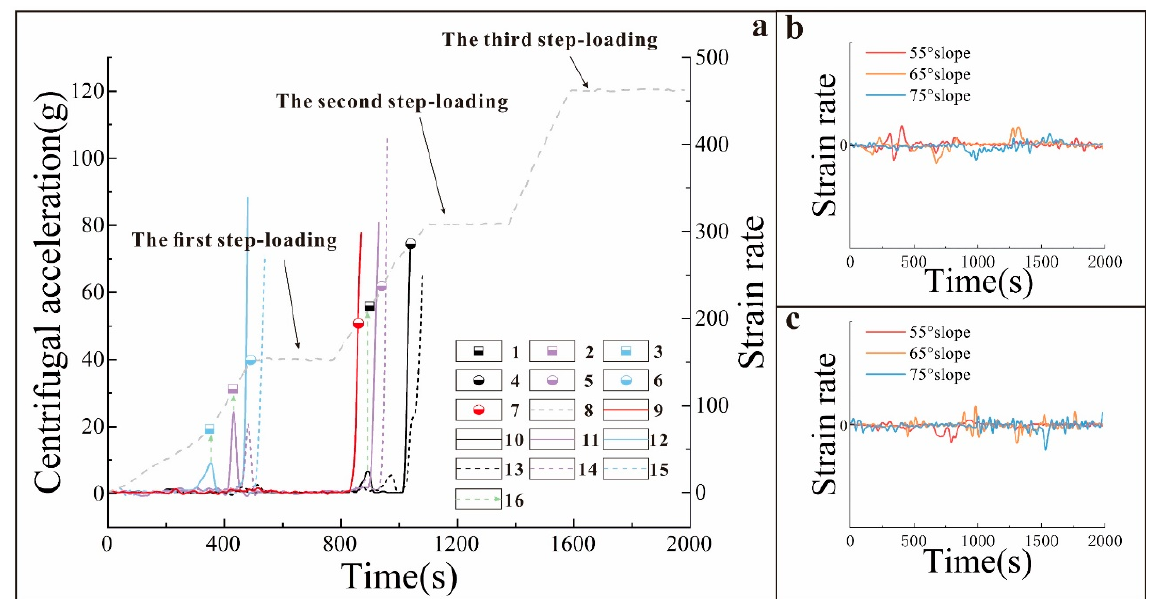
Figure 10. Model slope strain rate curves, ( a ) acceleration values and strain rate of key nodes in the development of the toppling bending zone, 1 rupture of 55° slope foot, 2 rupture of 65° slope foot, 3 rupture of 75° slope foot, 4 first-level toppling zone of 55° slope, 5 first-level toppling zone of 65° slope, 6 first-level toppling zone of 75° slope, 7 s-level toppling zone of 75° slope, 8 centrifugal acceleration curve, 9 S4 strain rate of 75°slope, 10 S1 strain rate of 55° slope, 11. S1 strain rate of 65° slope, 12. S1 strain rate of 75° slope, 13. S5 strain rate of 55° slope, 14. S5 strain rate of 65° slope, 15. S5 strain rate of 75° slope, 16. curve crest corresponding to rupture of slope foot. ( b ) slope of S3 strain rate curves, ( c ) slope of S4 strain rate curves.